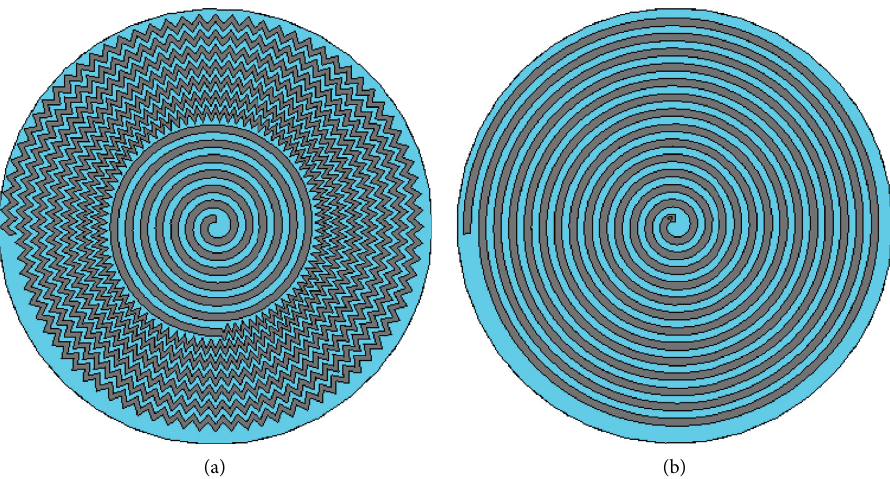
Figure 2: Simulated antenna models. (a) The proposed SAAS antenna. (b) The classical SAAS antenna.